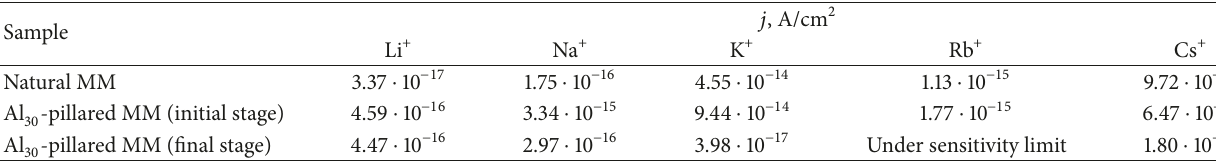
Table 1: Thermal emission current density of M + ions ( 𝑇 = 805